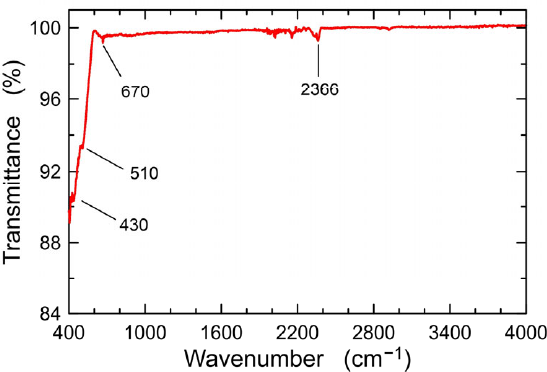
Figure 3. FTIR spectrum for the ZnO powder in the range of 400–4000 cm − 1 .